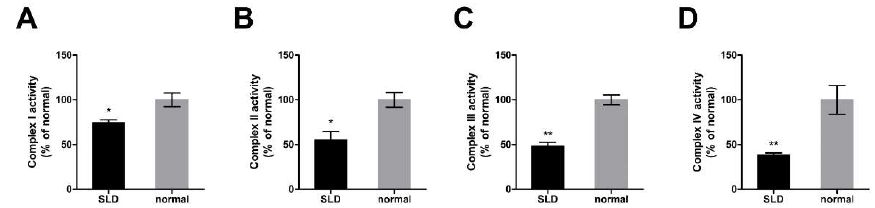
Figure 2. Reduced enzymatic activity of OXPHOS complexes in SLD chicken skeletal muscle. ( A ) Enzymatic activity of complex I was measured by the change in absorbance of NADH in SLD and normal chicken skeletal muscle. ( B ) Enzymatic activity of complex II was measured by the change in absorbance of DCIP in SLD and normal chicken skeletal muscle. ( C ) Enzymatic activity of complex III was measured by the change in absorbance of reduced cytochrome c in SLD and normal chicken skeletal muscle. ( D ) Enzymatic activity of complex IV was measured by the change in absorbance of reduced cytochrome c in SLD and normal chicken skeletal muscle. Data are expressed as means ± SEM, * p < 0.05; ** p < 0.01; *** p < 0.001.